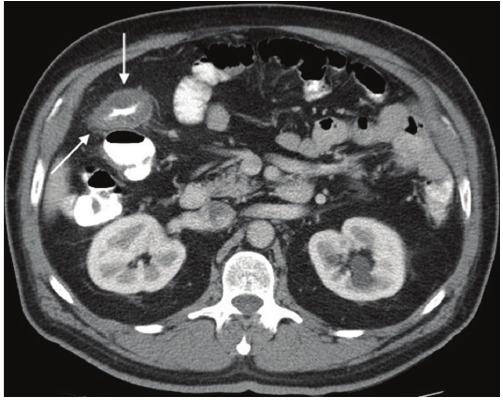
Figure 1: Tubular adenoma removed with snare cautery.